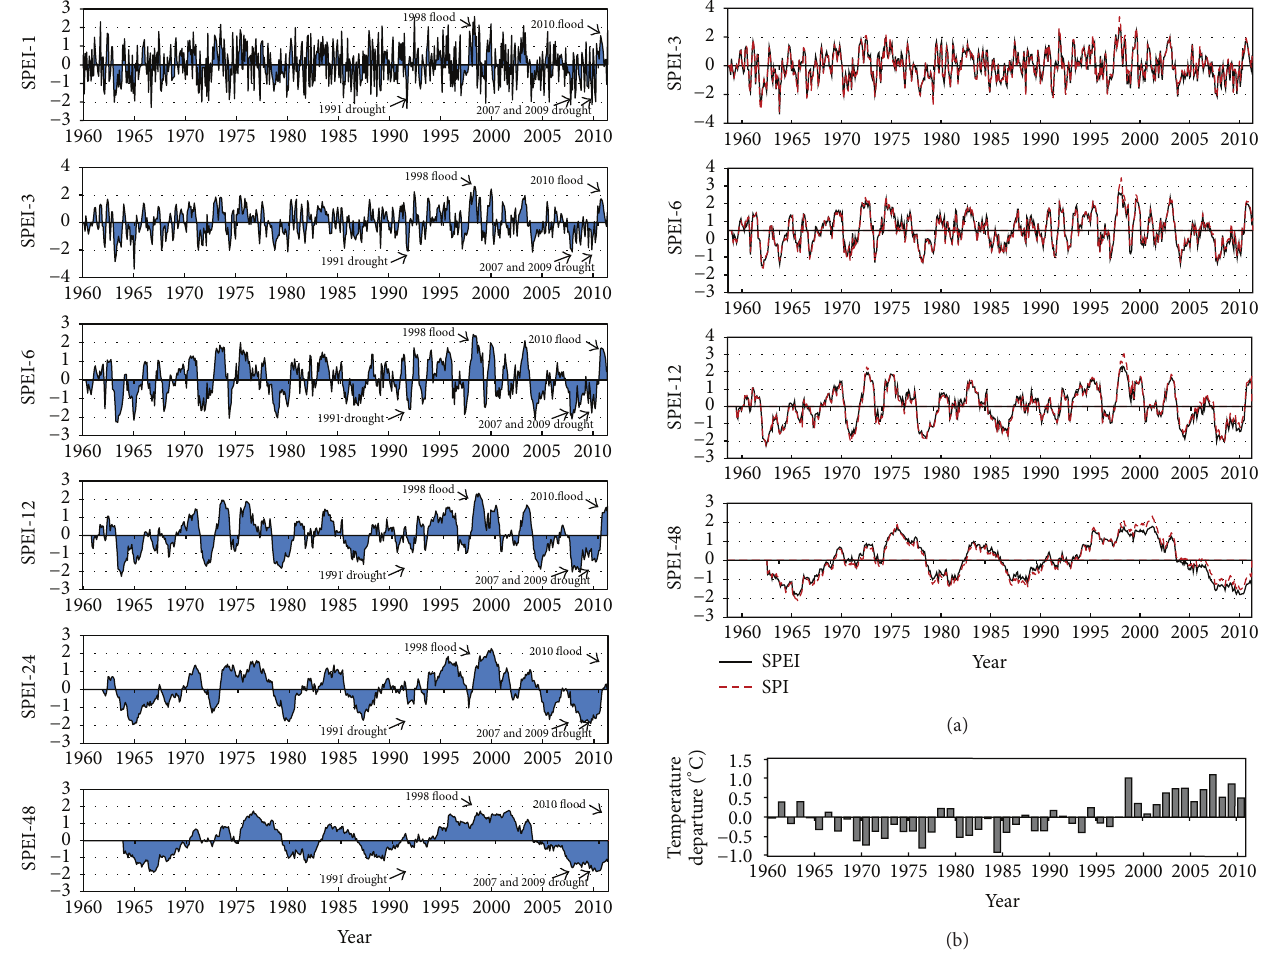
Figure6:(a)ComparisonofmultitimescalesofSPEIandSPIduring 1960–2010; (b) variation of annual temperature departures during